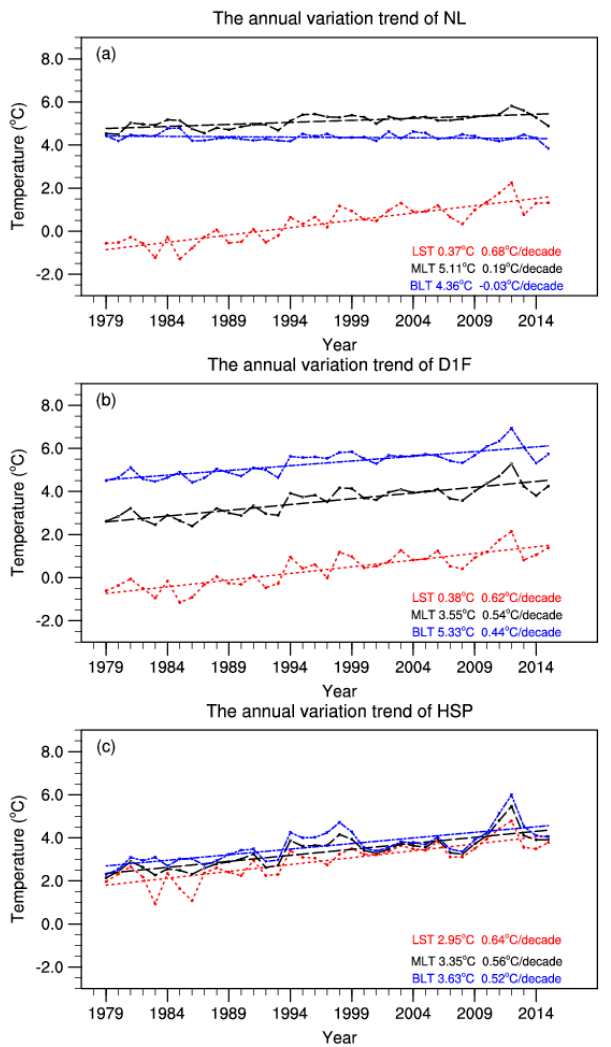
Figure 4. Annual LSWT (red), MLT (black) and BLT (blue) and their trends in S-NL ( a ), S-HSP ( b ) and S-D1F ( c ) Monthly LSWT.